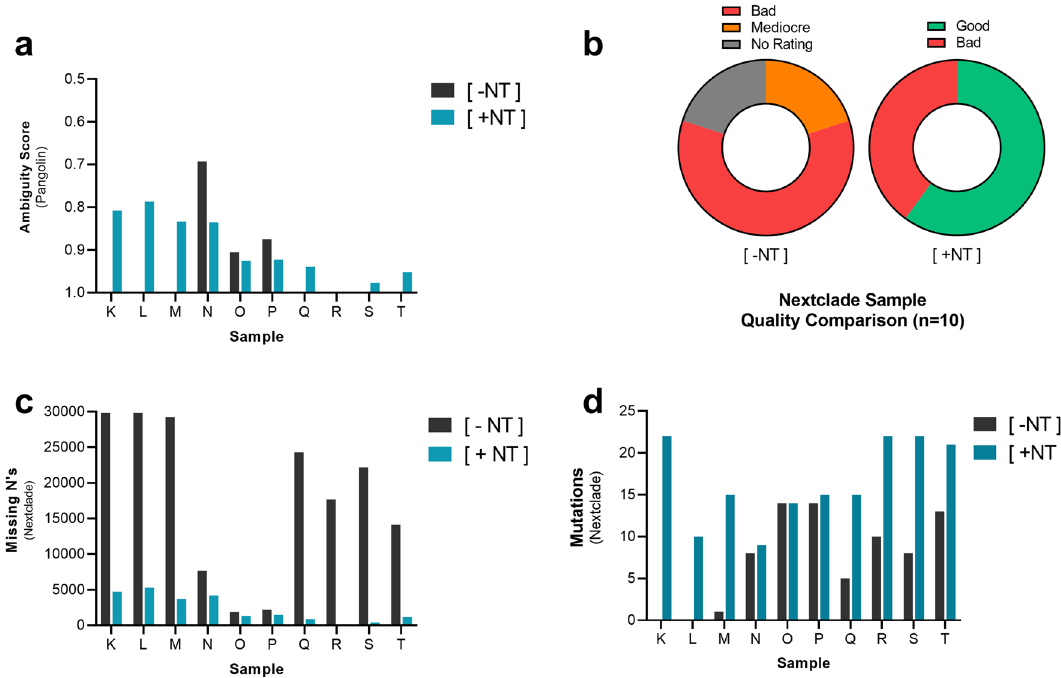
Figure 5. Magnetic Hydrogel Particles(Nanotrap Particles) Improve Bioinformatics Tools when analyzing SARS-CoV-2 Samples. 10 SARS-CoV-2 positive diagnostic remnant samples were processed using Nanotrap Particle Workflow 3 [+ NT] or the MagMAX kit alone [− NT]. Samples underwent sequencing on a ONT MinION R.9 flow cell and were analyzed by Pangolin (a) , and Nextclade, which assessed: QC score comparison of all 10 samples (b) , total genome locations unable to be characterized per sample (missing n’s, less = better) (c) , total mutations detected per sample (d)